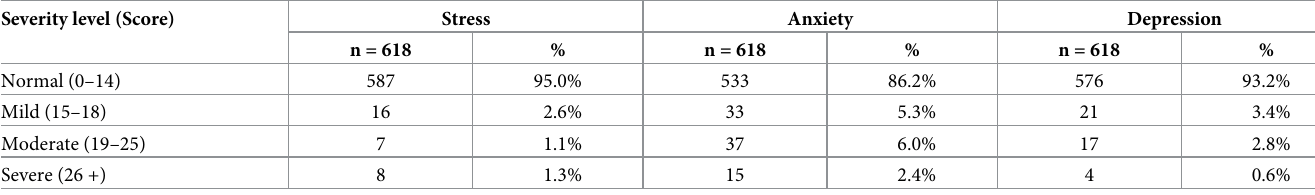
Table 3. Prevalence and severity of stress, anxiety and depression. Severity level